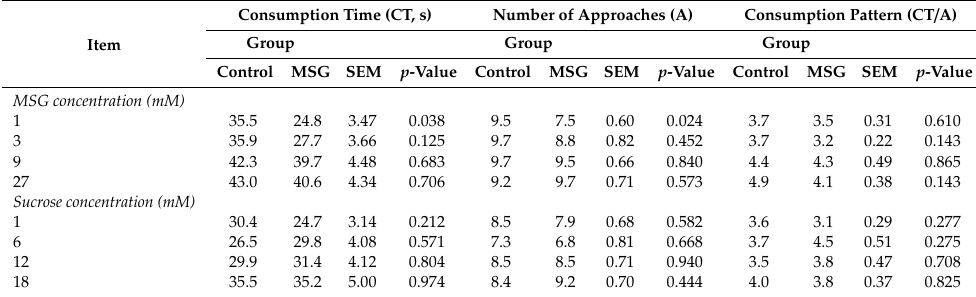
Table 6. Consumption time, number of approaches, and consumption patterns of different concentrations of MSG and sucrose solutions in post-weaning pigs born from control or MSG-fed sows 1 .